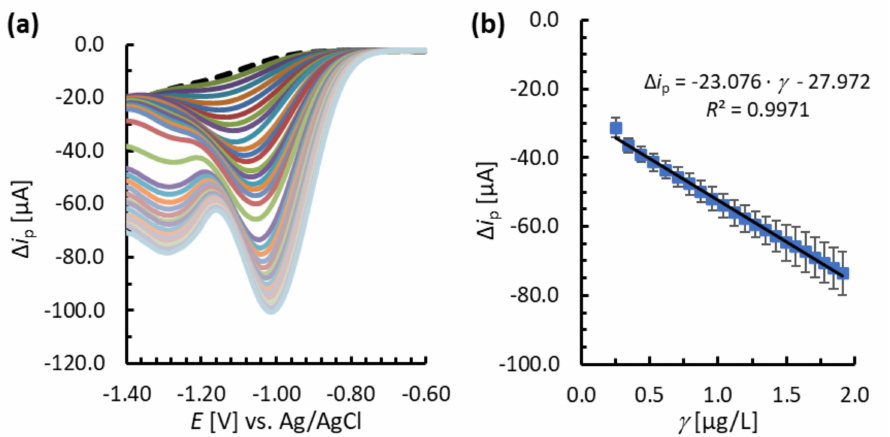
Figure 7. ( a ) SWAdSV measurements with increasing Cr(VI) concentration using BiFE/MNPs@ SiO 2 @Lys (measurement of the blank is shown with the dashed line) and ( b ) the corresponding linear calibration curve (error bars represent standard deviation of replicate measurements). The measurements were performed in 0.1 M acetate buffer containing 0.2 M KCl and 5mM DTPA. The accumulation step, in which the Cr(III)-H 2 DTPA reduction product is formed and adsorbed, was performed at E acc = − 0.40 V and t acc = 60